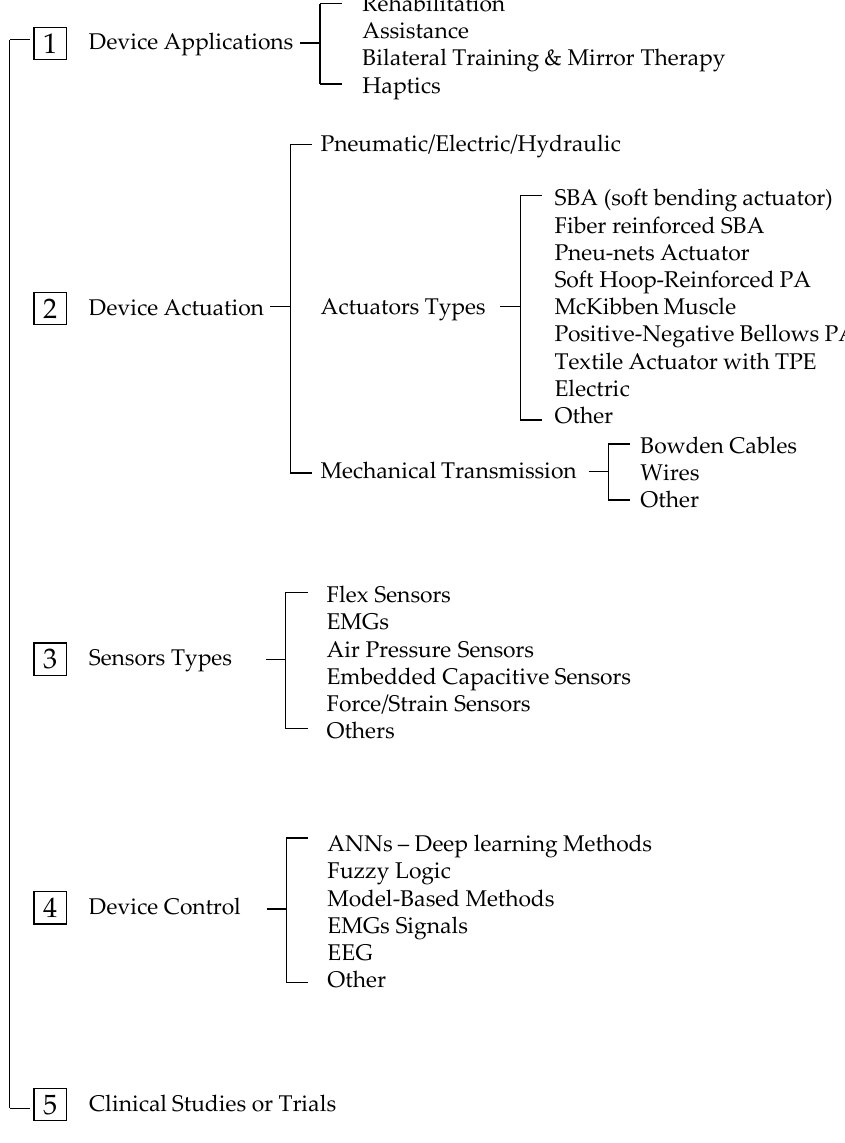
Figure 6. Adopted taxonomy for the analytical